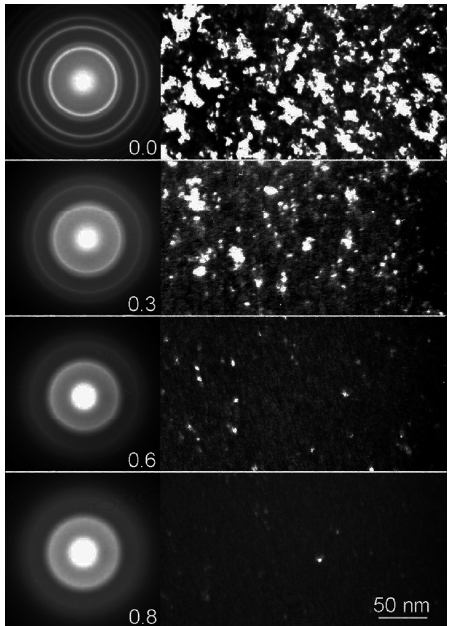
Figure 4. Sequence of dark ‐ field TEM images and associated electron ‐ diffraction patterns showing the effects of Xe ‐ ion irradiation on nanocrystalline ZrO 2 . The number in the bottom right corner of each diffraction pattern is the ion dose in dpa. The dark ‐ field images were taken with the objective aperture centered over the bright (111) diffraction ring [67].